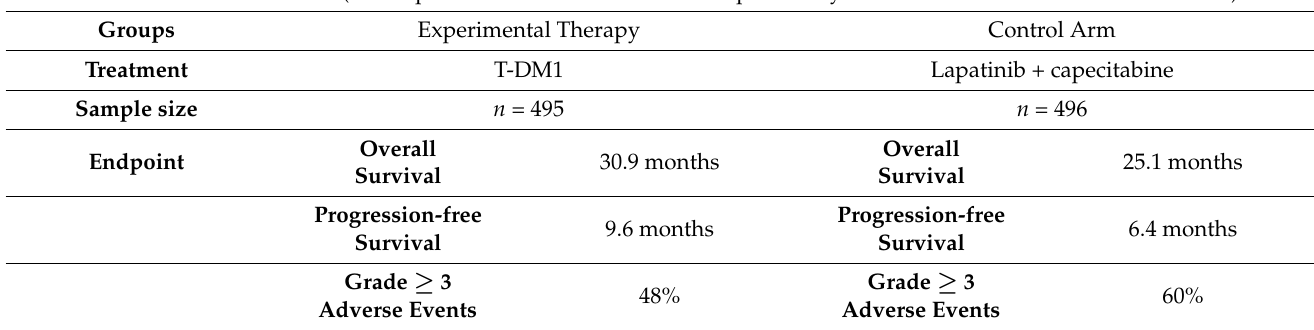
Table 3. Summary of Phase III clinical trials that led to FDA approval of